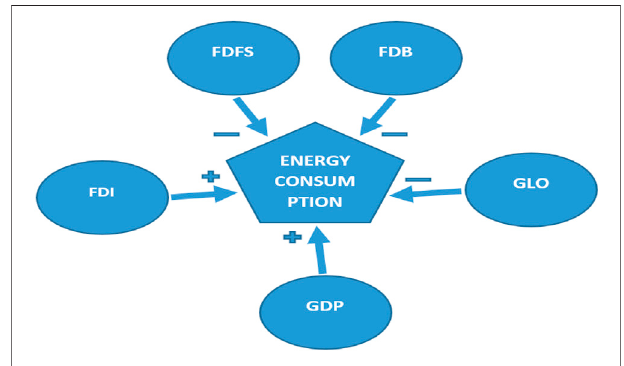
FIGURE 1 | Graphical representation of the long-run